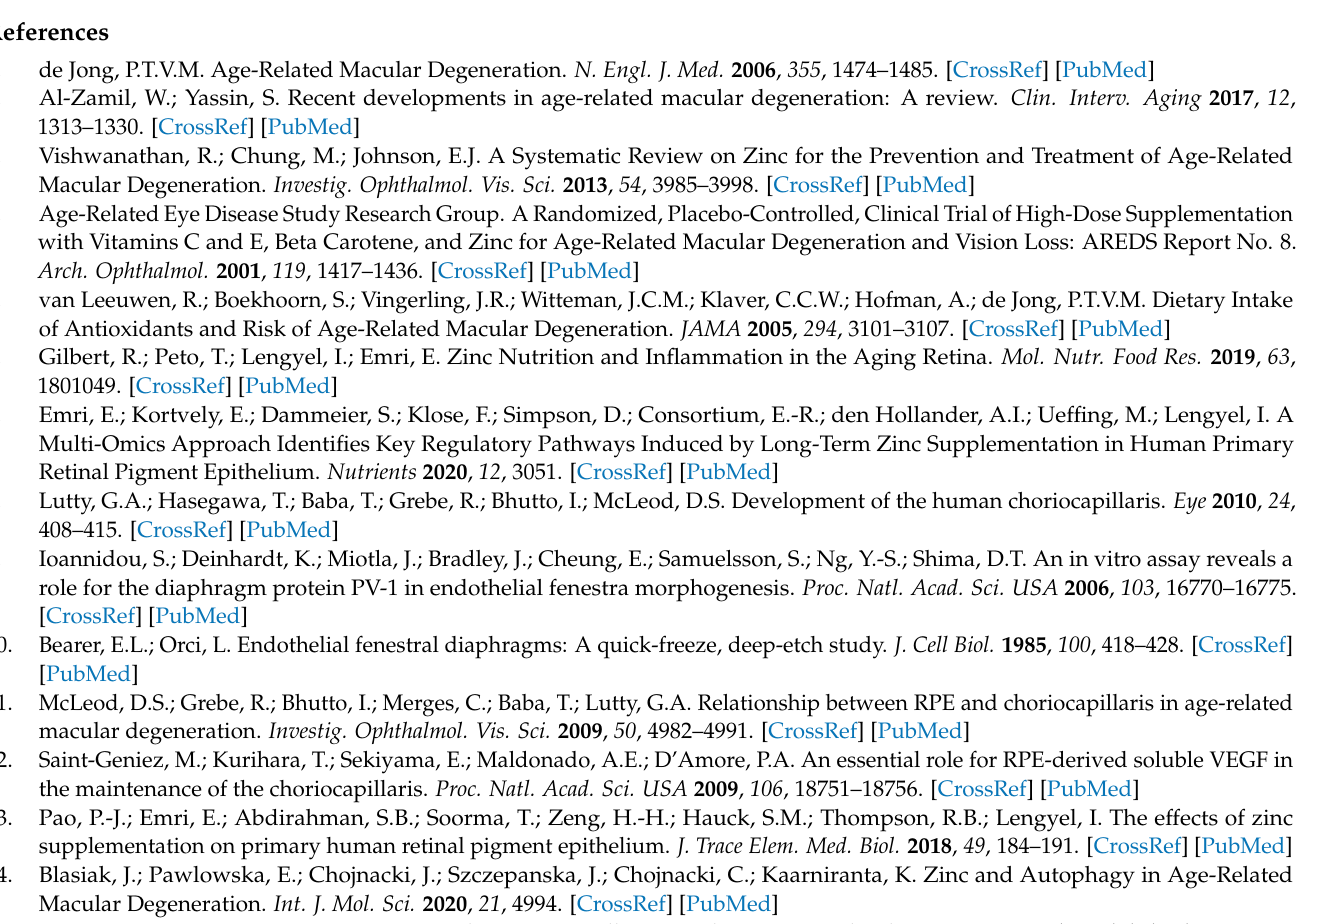
Macular Degeneration. N. Engl.